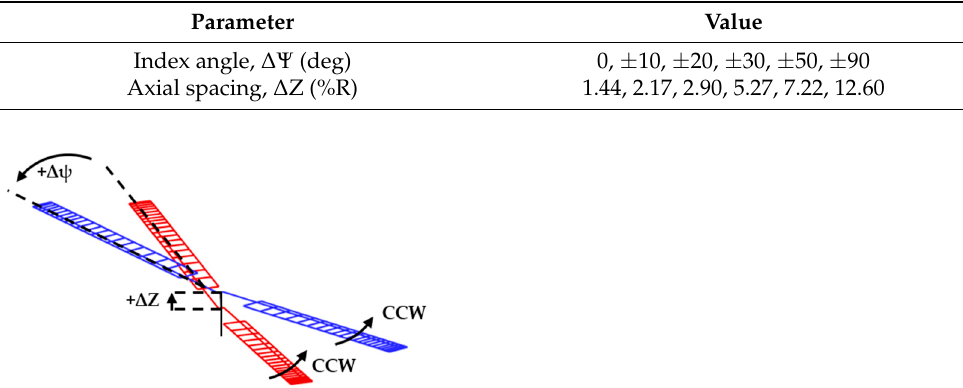
Table 2. Various index angles and axial spacings.